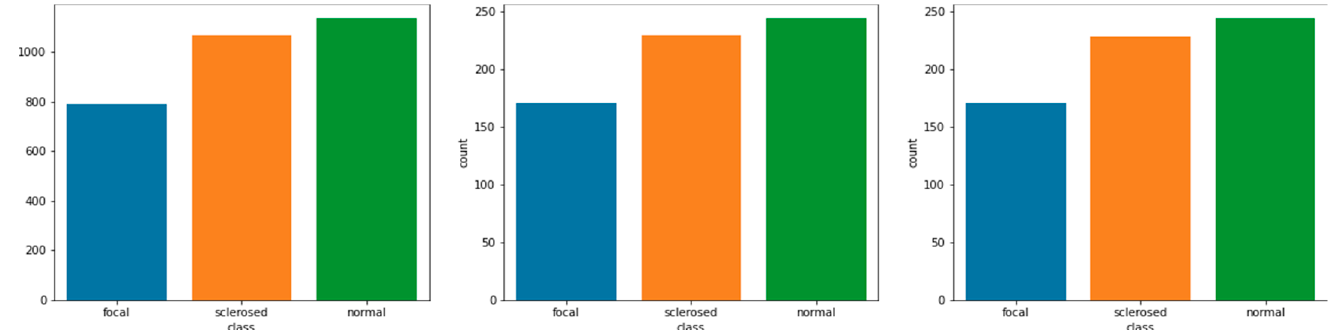
Figure 2. Sample Images of the validation set for the focal-segmental, sclerosed and normal glomeruli.